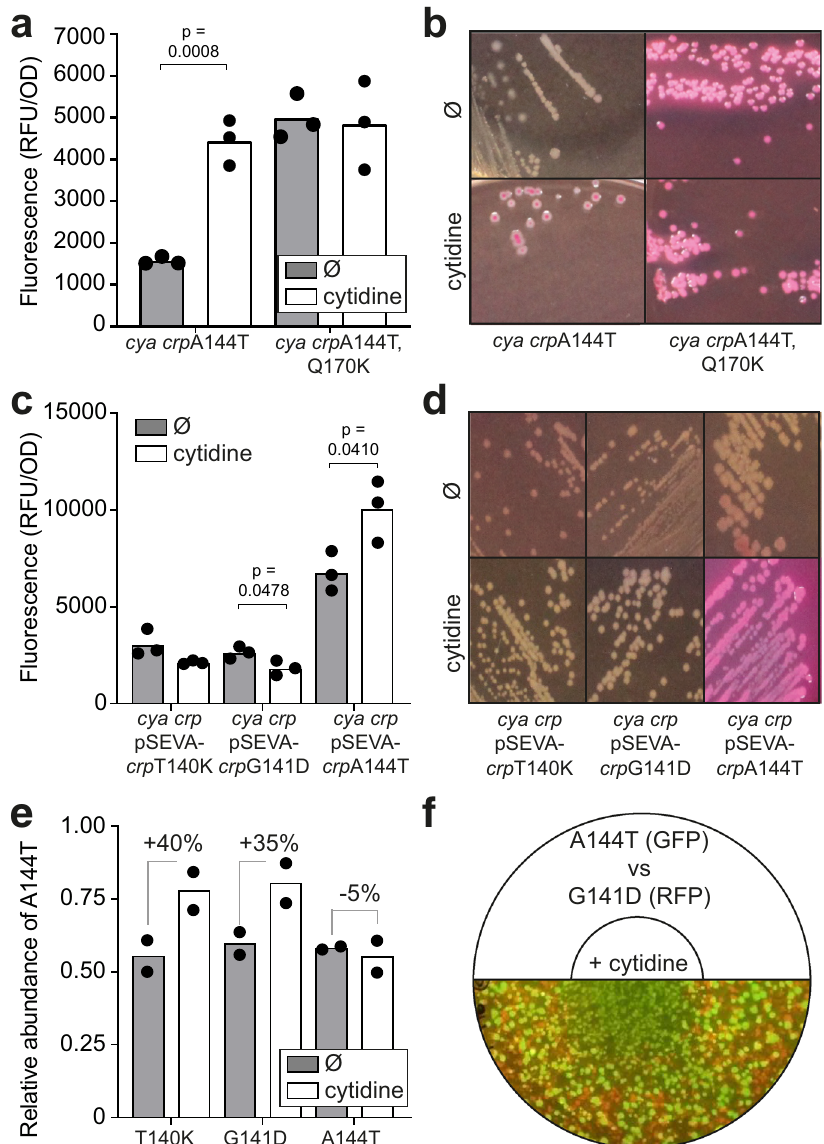
Fig. 6 In vivo activity and fi tness effects of different Crp mutants. a Effect of the additional Crp mutation Q170K in the presence (white) or absence (grey) of exogenously added cytidine assayed with the GFP reporter. No supplementation (Ø) serves as a negative control. Data represent the average of three biological replicates. b Phenotypes of Crp A144T Q170K compared to A144T on maltose MacConkey agar. c Relative activities of Crp* mutations